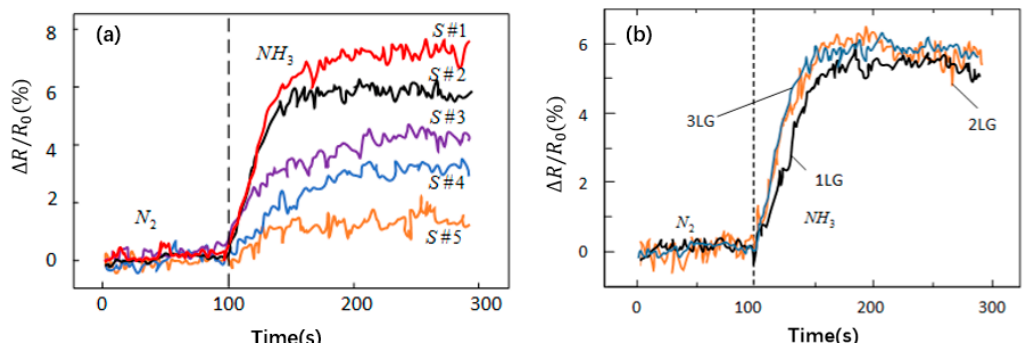
Figure 5. ( a ) Comparison of the response of monolayer, double and triple layer graphene to NH 3 with a flow rate of 200 mL/min; and ( b ) The change in response due to L/w ratio and surface area of graphene with NH3 flowing at 200 mL/min [56].